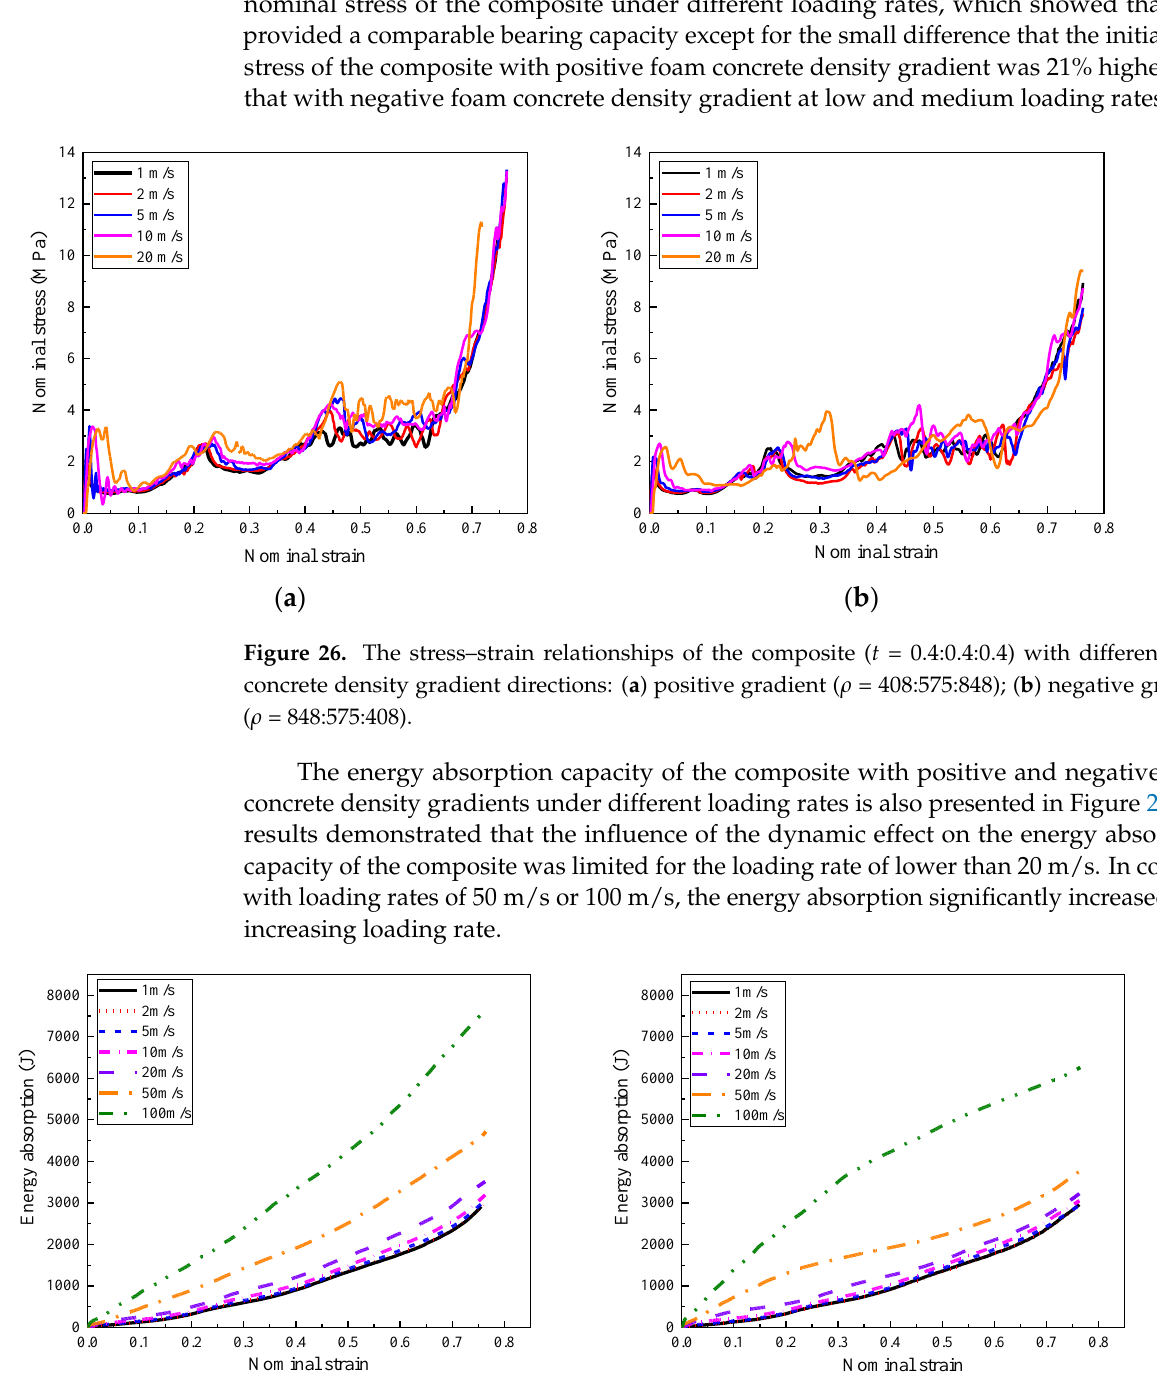
Figure 25. The stress – strain relationships of the composite calculated from the contact forces be- tween the composite and loading plate and supporting plate ( t = 0.4:0.4:0.4 and ρ = 848:575:408): ( a ) 1 m/s, 2 m/s, and 5 m/s; ( b ) 10 m/s and 20 m/s.